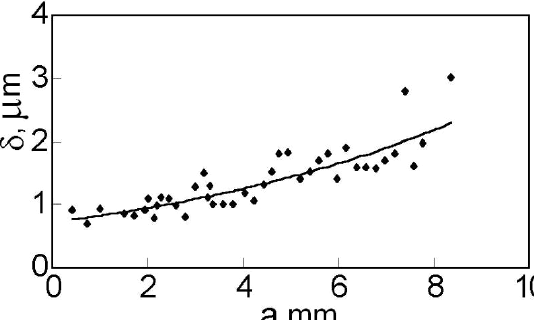
Figure 9: Striation spacing value  against the minor axis, a , of semi-elliptically crack appeared in the turbine disk bench-tested by equivalent cyclic loading in an NK8-2u engine.